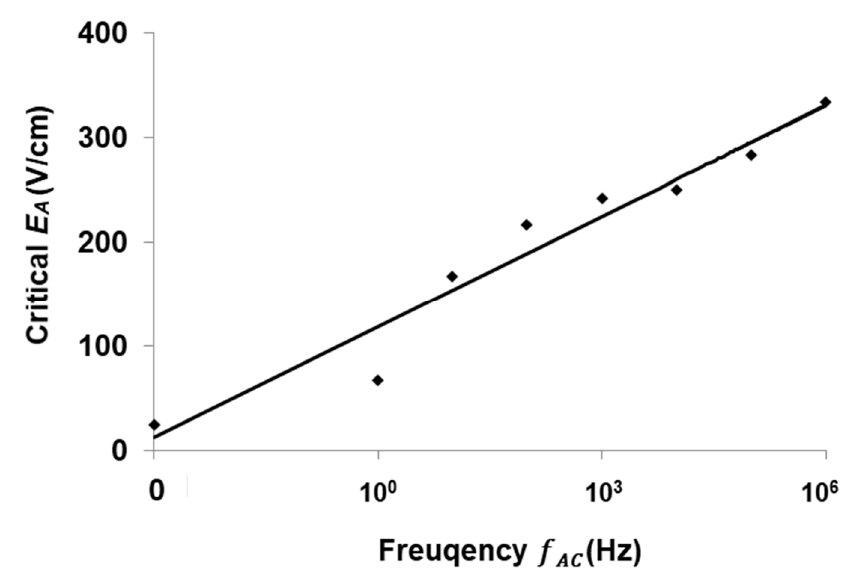
Figure 8. Critical electric field vs. the f AC for mixing enhancement. Flow rate was kept at 5 µ L/min with γ = 10 .